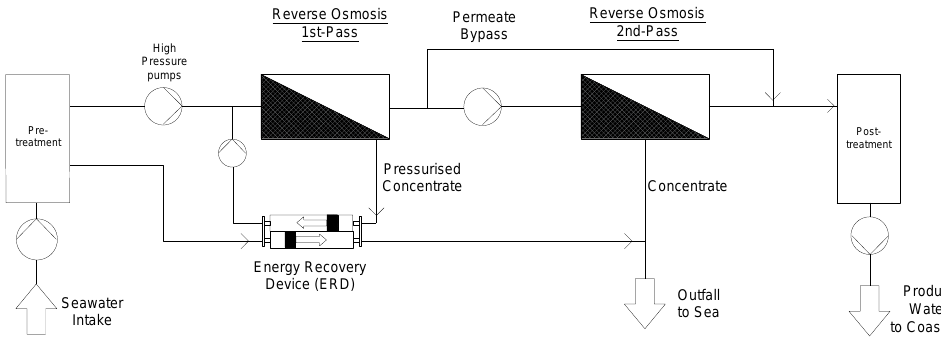
Figure 4. Simplified flow chart of two-pass reverse osmosis desalination with energy recovery.